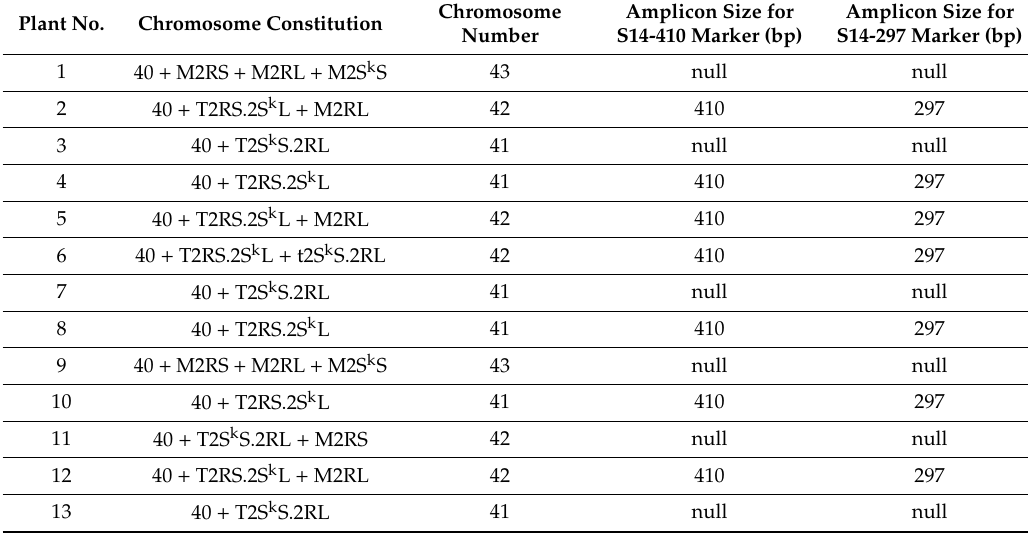
Table 2. Chromosome constitutions and Lr54 + Yr37 SSR marker analysis of triticale plants carrying divided 2S k chromosome.